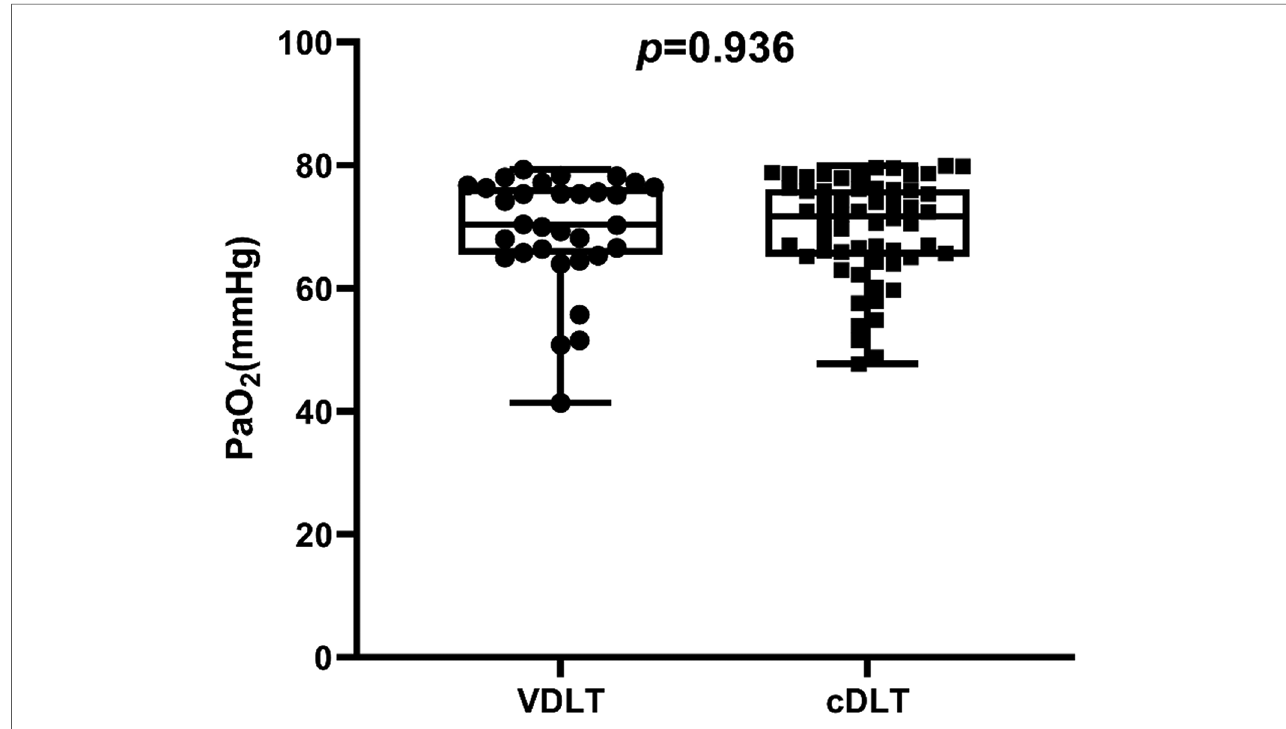
FIGURE 3 The margin of PaO 2 after OLV in patients with hypoxemia. The centerlines show the medians; the box limits indicate the 25th and 75th percentiles; whiskers extend to data points that are less than 1.5×interquartile ratios away from the fi rst/third